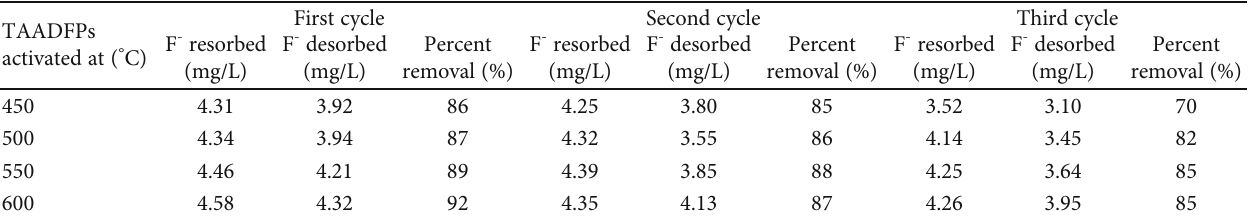
(Figure 9). The correlation coe ffi cient R 2 can be obtained from the graph.